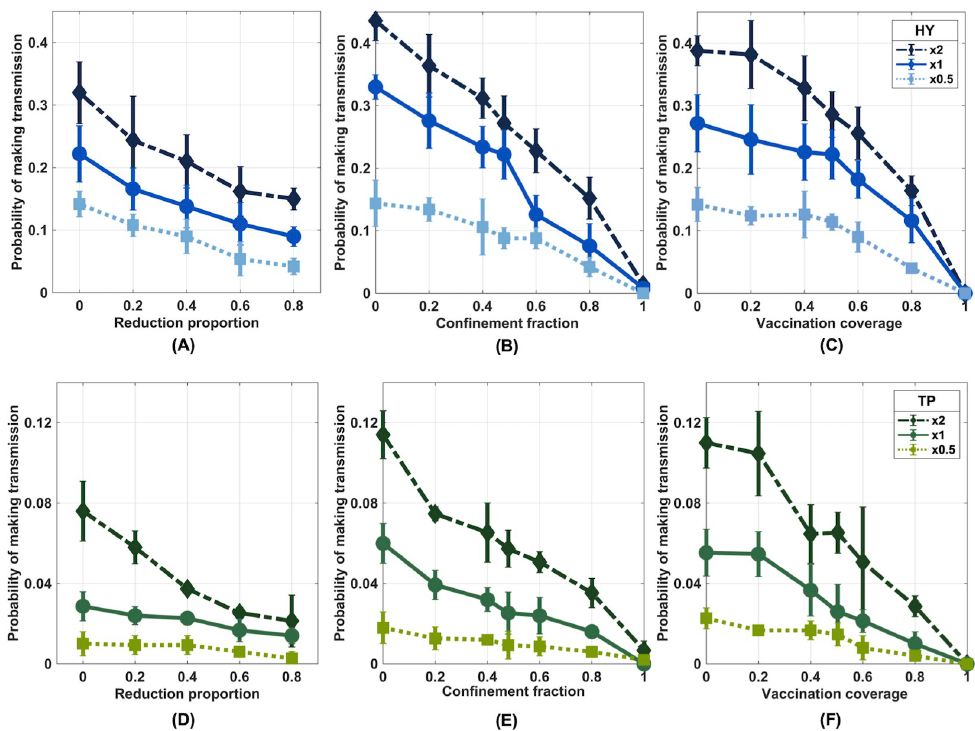
Fig 6. Impact of intervention strategies on the likelihood of rabies transmission in Hatyai (A, B, and C) and Tepha (D, E, and F). The likelihood of rabies transmission caused by an imported infected dog under the intervention scenarios of (A and D) reducing the dog population size, (B and E) reducing the fraction of free-roaming dogs, and (C and F) increasing the mass vaccination coverage. A sensitivity analysis where the dog traveling distances are scaled by factors of 0.5 (x0.5) and 2 (x2) was also shown (dashed